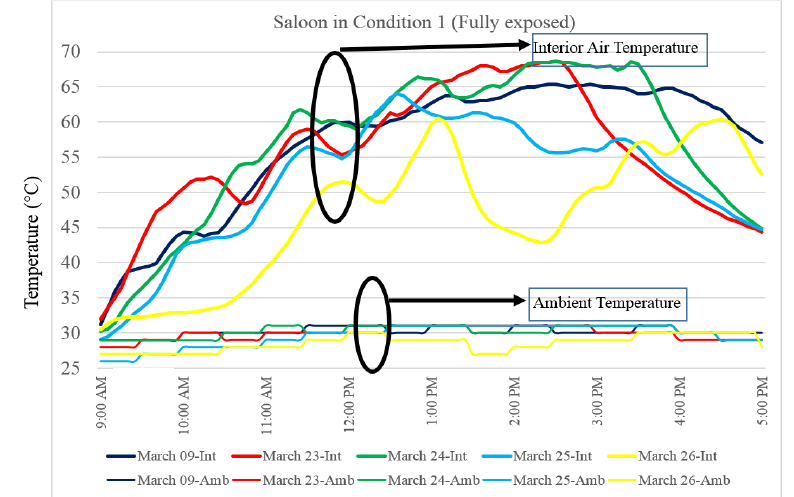
Figure 10. Condition 1 for Saloon type